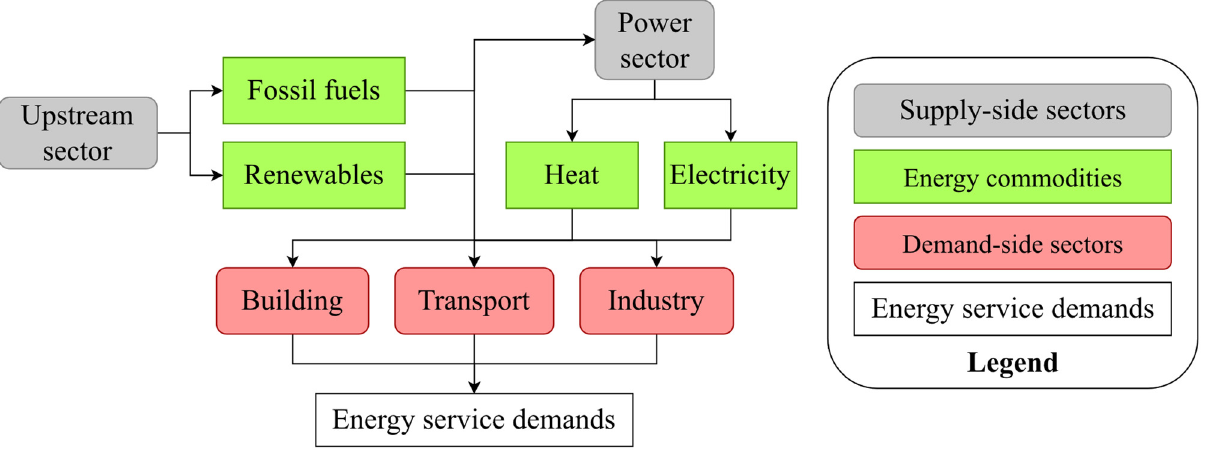
Figure 1. Schematic representation of the general reference energy system of a bottom-up energy system optimization model.